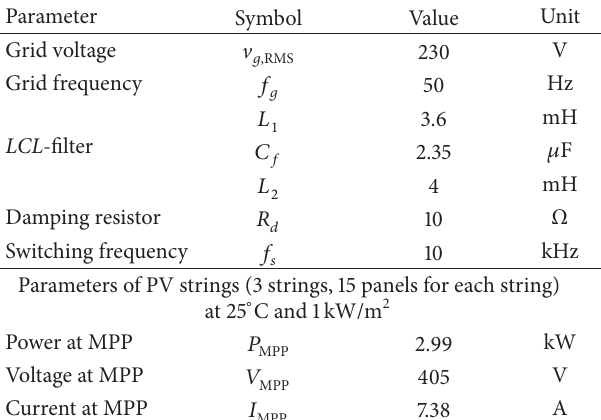
Table 2: System parameters for single-phase transformerless grid- connected PV